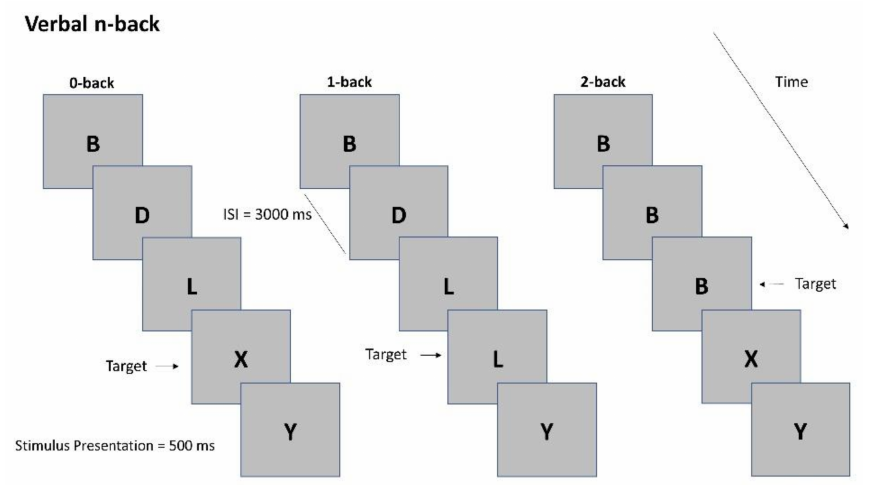
Figure 1. Example of N-back task under the 0-back, 1-back, and 2-back